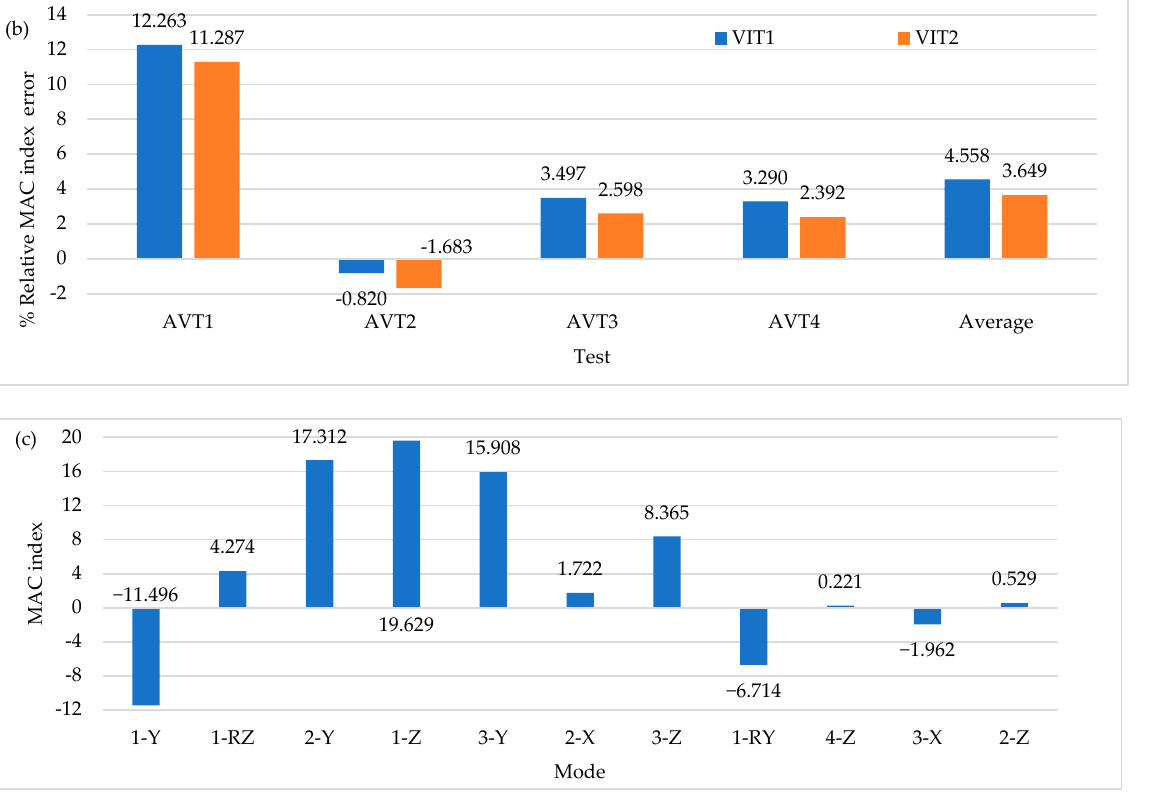
Figure 20. ( a ) Average values of MAC index ( b ) Percentage of relative MAC index error of excitation sources ( c ) Mode shape MAC index variation with respect to AVTs.